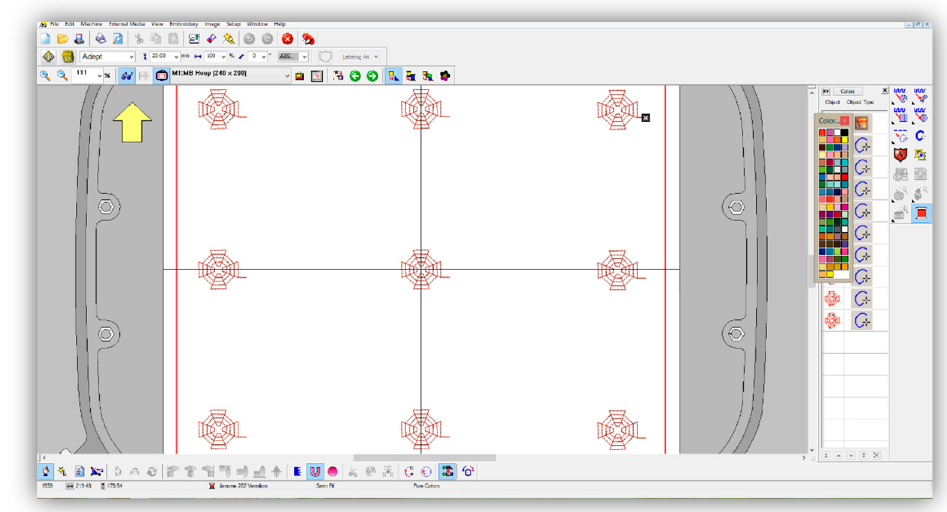
Figure 9. The development of a program for the sensors’ incorporation with Digitizer MB.